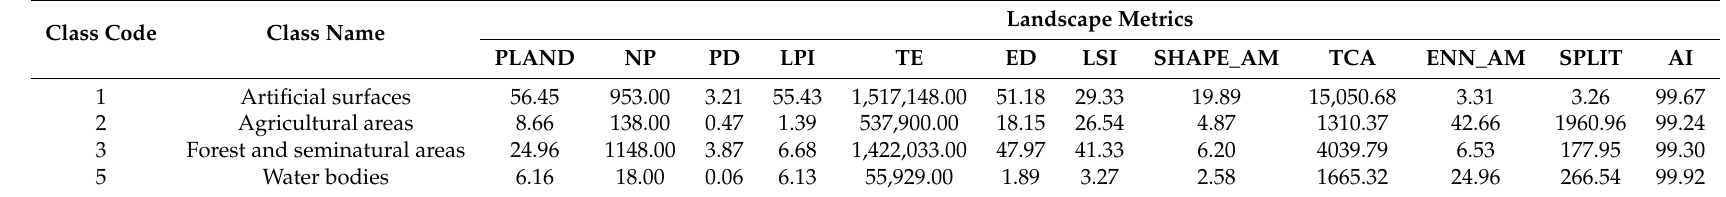
Table 11. Level 1 landscape metrics